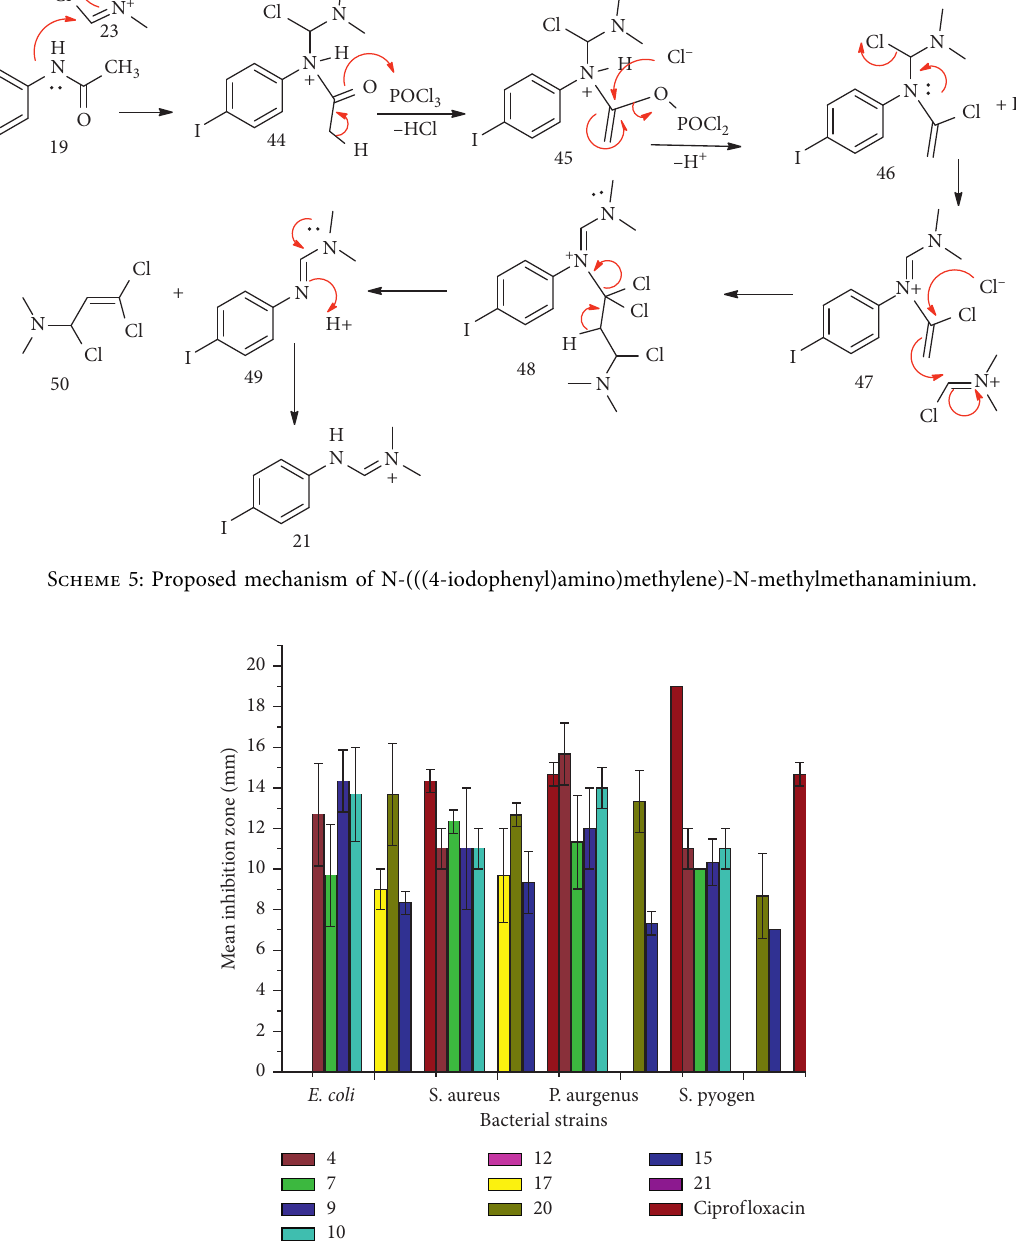
Figure 1: The inhibition zone (mm) of synthetic compounds at 0.1 μ g/ μ L. The error bar indicates the standard